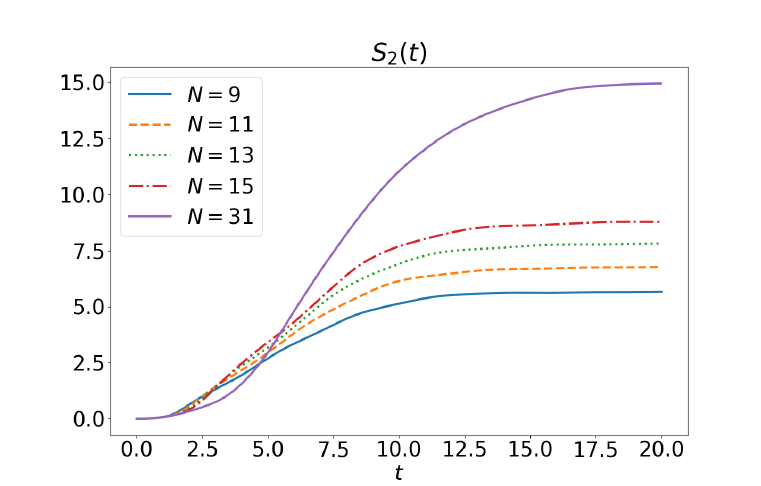
[ defined in Eq. (15) ] vs. t , for the same 2 (which is essentially the log of 2